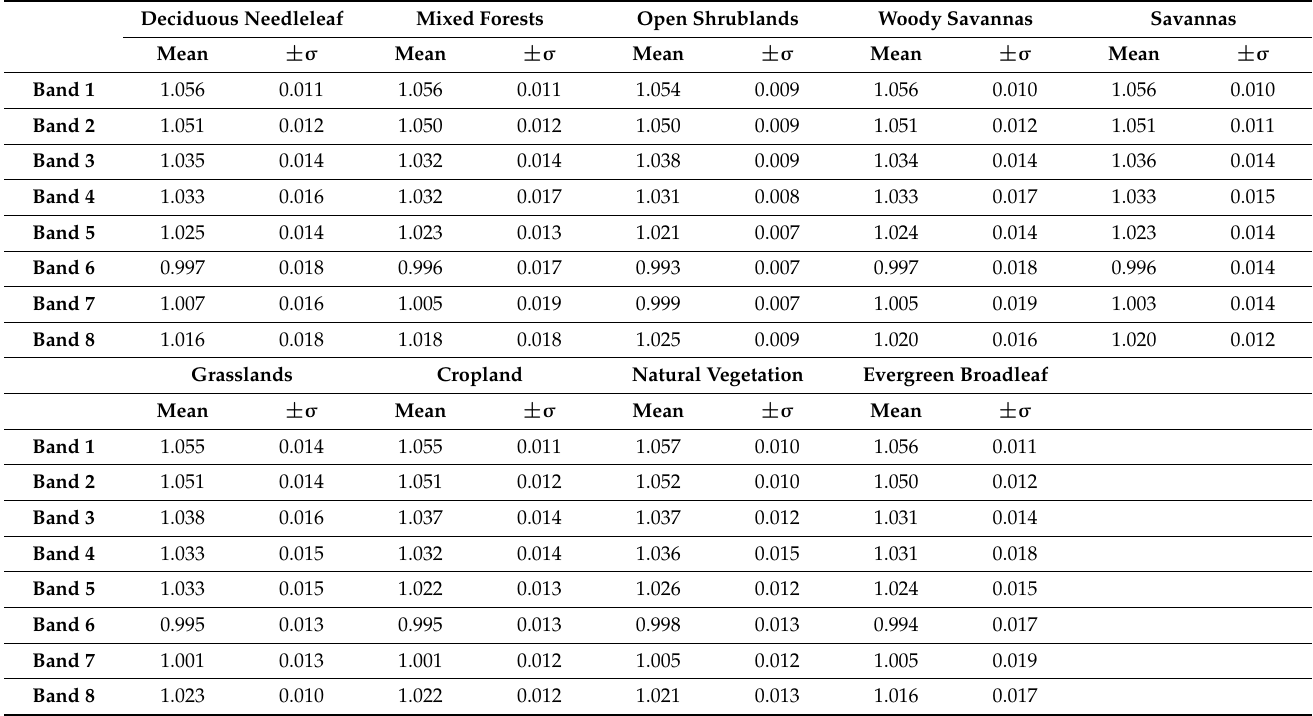
Table 5. Vegetation land cover types cross-calibration reflectance